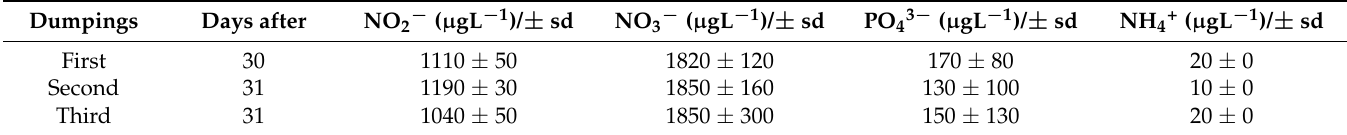
Table 4. Nutrient concentration of interstitial water of tanks with Rhizophora mangle seedlings with marine water (control). Dumpings